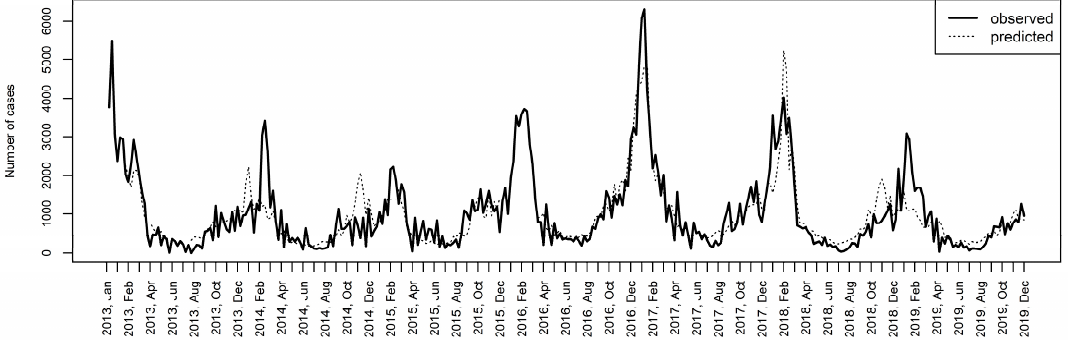
Figure 3. The observed and predicted (according to the model including temperature, PM 2.5 and the long-term trend as covariates) number of influenza-like illness cases. R 2 = 0.703.